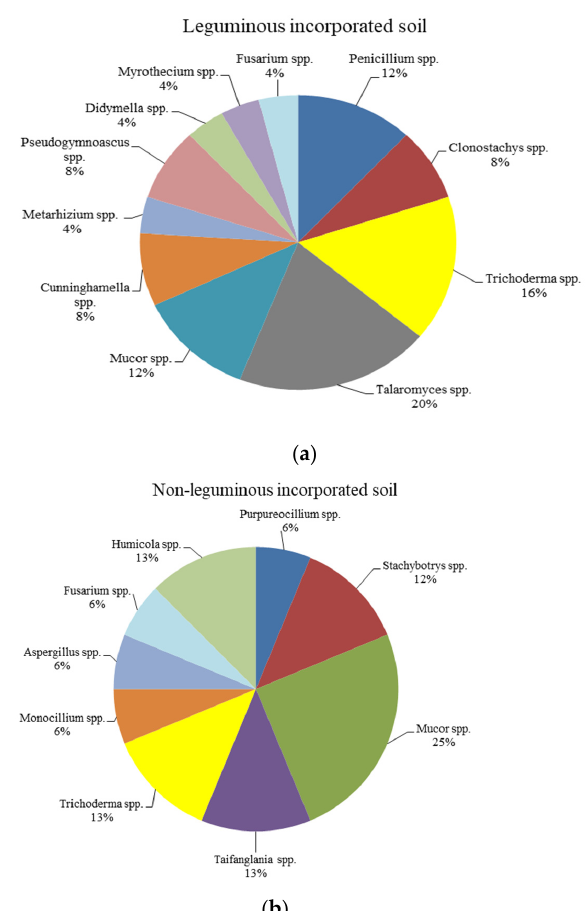
Figure 1. ( a ) Twenty-five strains isolated from leguminous-manure-incorporated soil, where the dominant genera were Penicillium , Talaromyces , and Trichoderma ; ( b ) seventeen strains isolated from non-leguminous-manure-incorporated soil, where the dominant genera were Mucor , Taifanglania , and Trichoderma. Table 1. ( a ) List of the fungi isolated from the soil incorporated with leguminous plant soil. ( b ) List of the fungi isolated from the soil incorporated with non-leguminous plant soil.